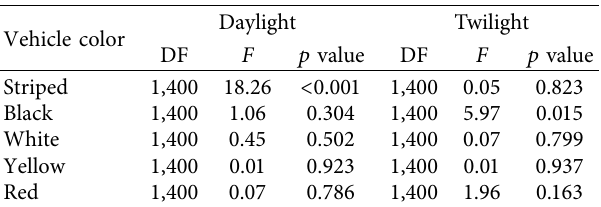
∗ Group p value is a general form of the contrast analysis, so if it is not found significant, the post hoc p values of that column will not be significant either. Therefore, the post hoc p values were not shown in the table. ∗∗ Due to space limitations, the F -values and the corresponding statistics of vehicle colors are not shown in the table. Table 9: Effects of vehicle size under the rear identification scenario.